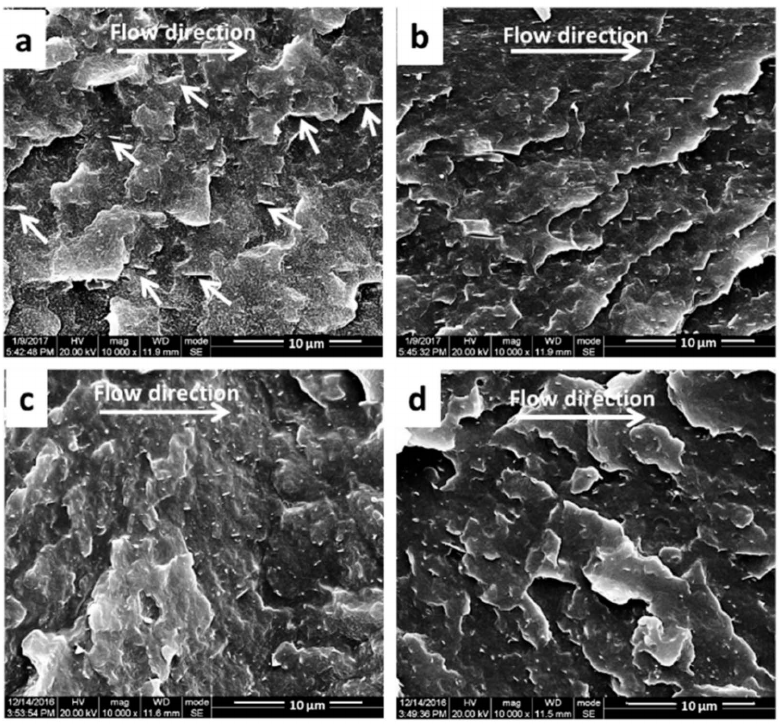
Figure 8. SEM images of the fractured surfaces of the shear layer ( a ) and the core layer ( b ) of PVDF/GP micro-part; the shear layer ( c ) and core layer ( d ) of PVDF/GP macro-part. (GP content: 1